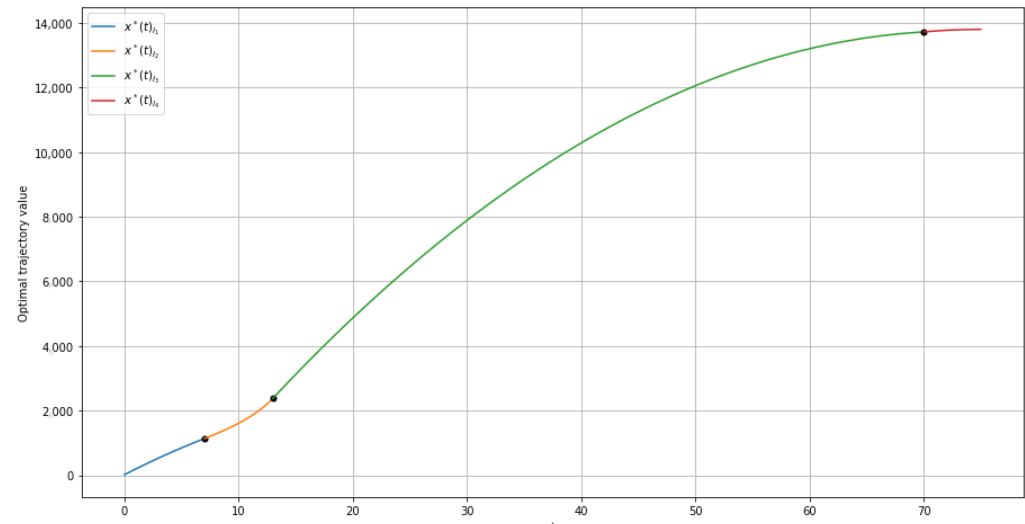
Figure 3. The optimal trajectory on four time subintervals connected by connectivity points—bold black dots x 1 , x 2 , x 3